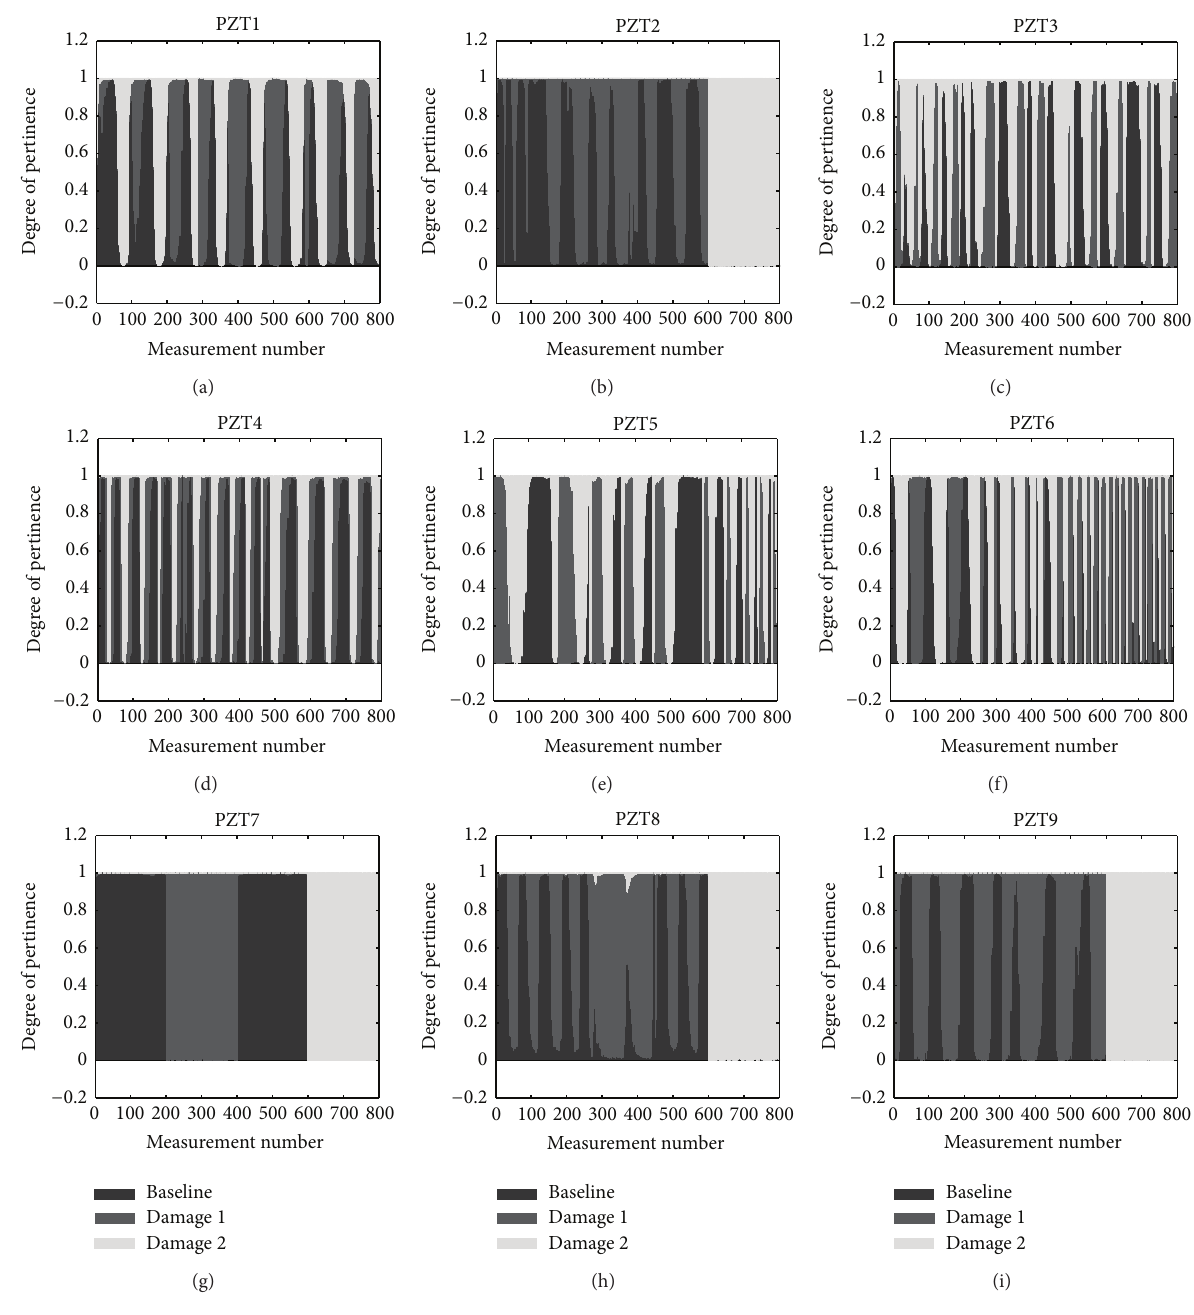
Figure 7: Final degrees of pertinence for the aircraft